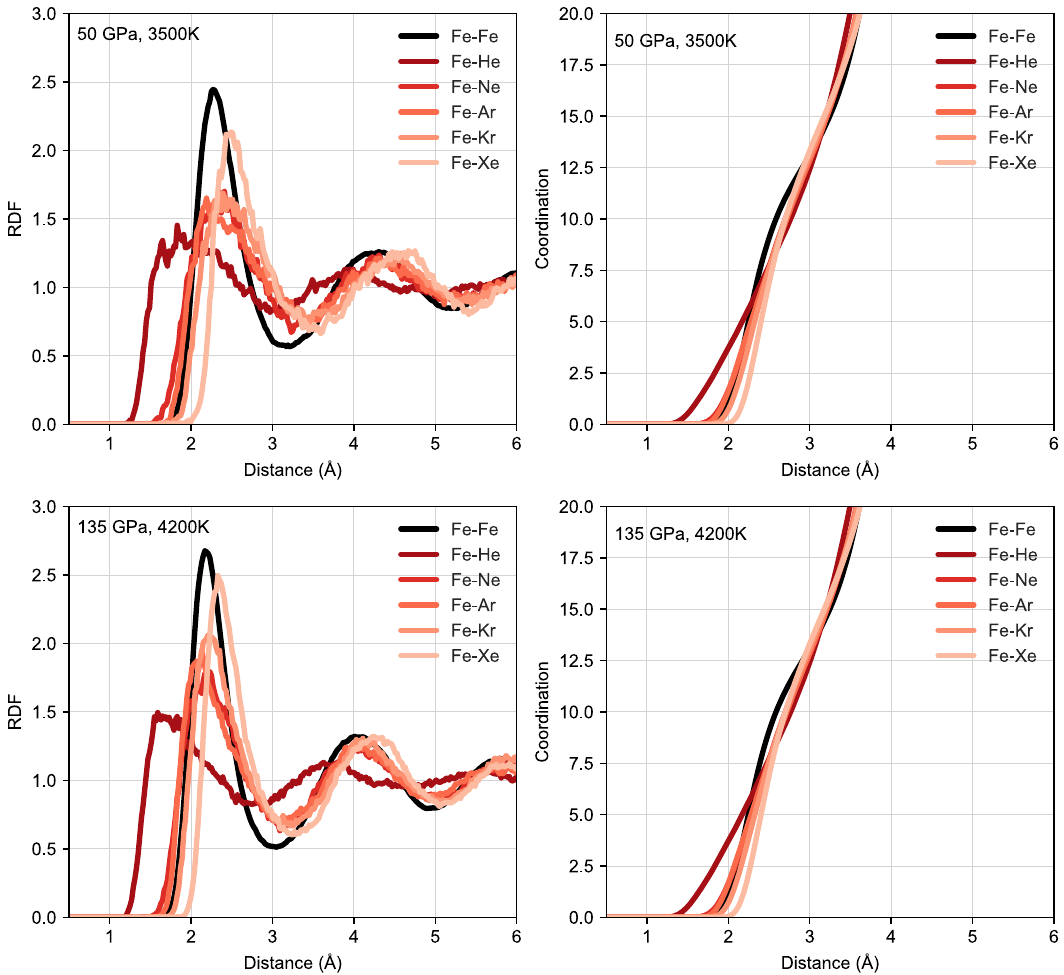
Fig. 4 Radial distribution function and coordination numbers for noble gas containing liquid iron. Calculation results for liquids at 50 GPa, 3500 K and 135 GPa, 4200 K. For better comparison, the coordination numbers of noble gases with Fe are scaled by the number of Fe atoms to the number of noble gas atoms.